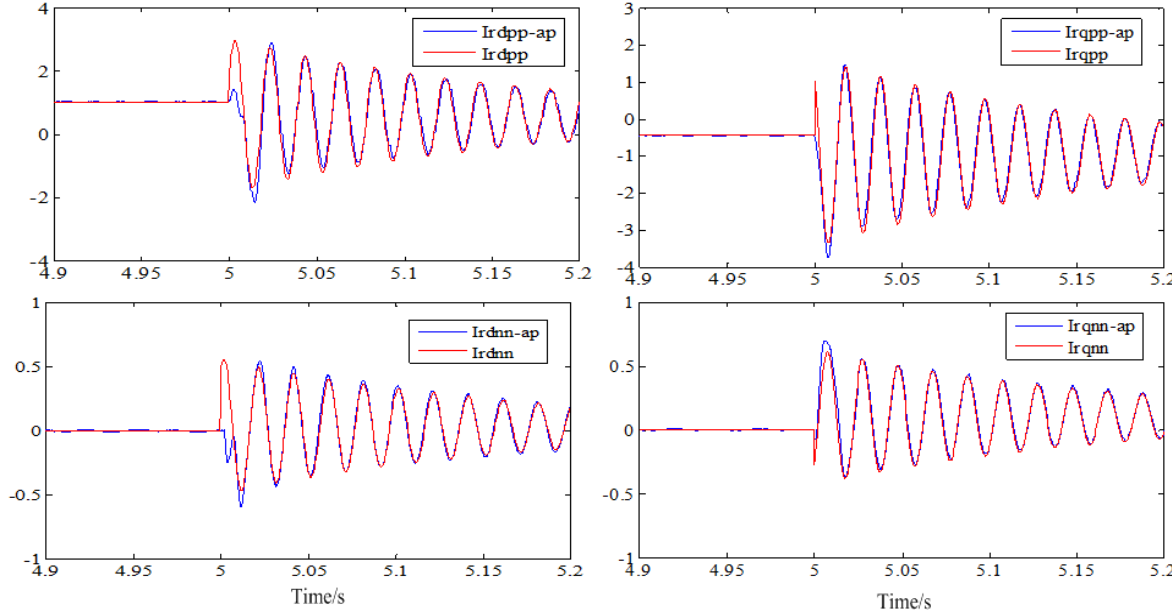
Figure 7. d -axis and q -axis components of the rotor current in the ( dq ) + and ( dq ) − reference